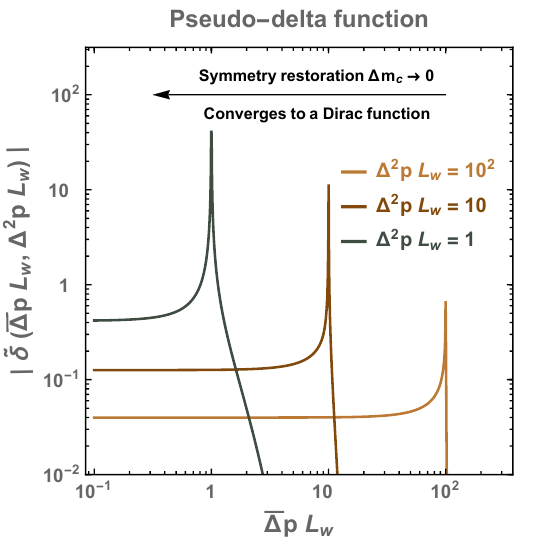
Figure 9 . The function ˜ δ ( ¯∆ pL w , ∆ 2 pL w ) tends to the Dirac δ function for ∆ 2 p ≡ ∆ m 2